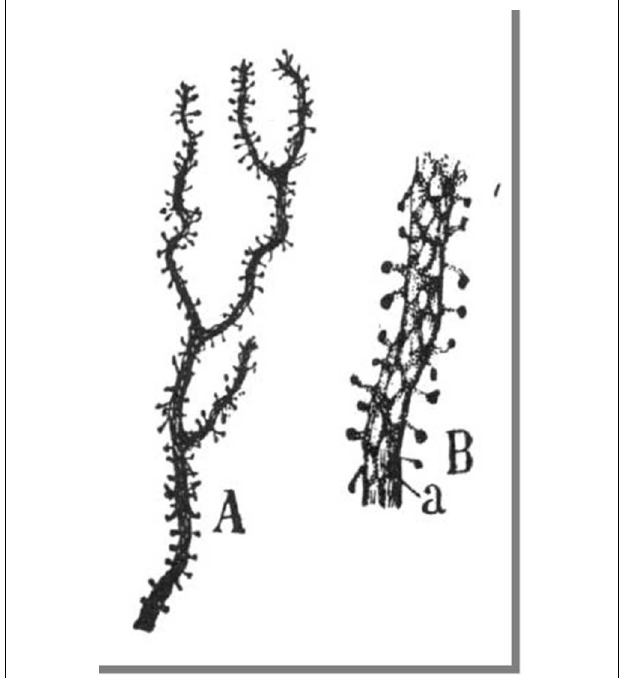
FIGURE 1 | Original illustrations from Cajal, displaying dendritic spines from a cerebellar Purkinje cell, as drawn from Golgi material (Ramón y Cajal, 1899c ). Reproduced with permission from “Herederos de Santiago Ramón y Cajal.”